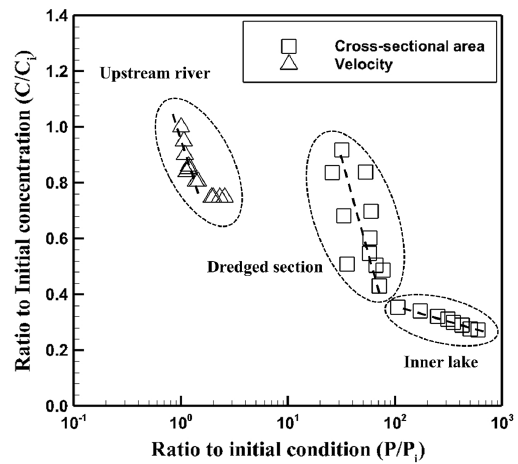
Figure 10. The sensitivity analysis in the change of concentration with cross-sectional area and velocity change